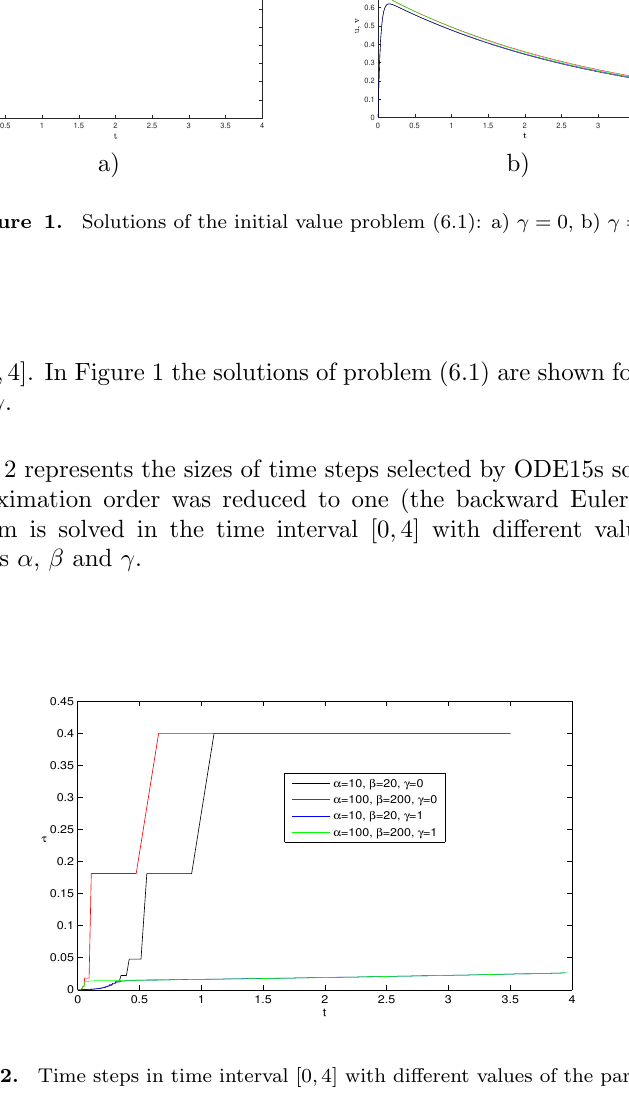
Figure 2. Time steps in time interval [0 , 4] with different values of the